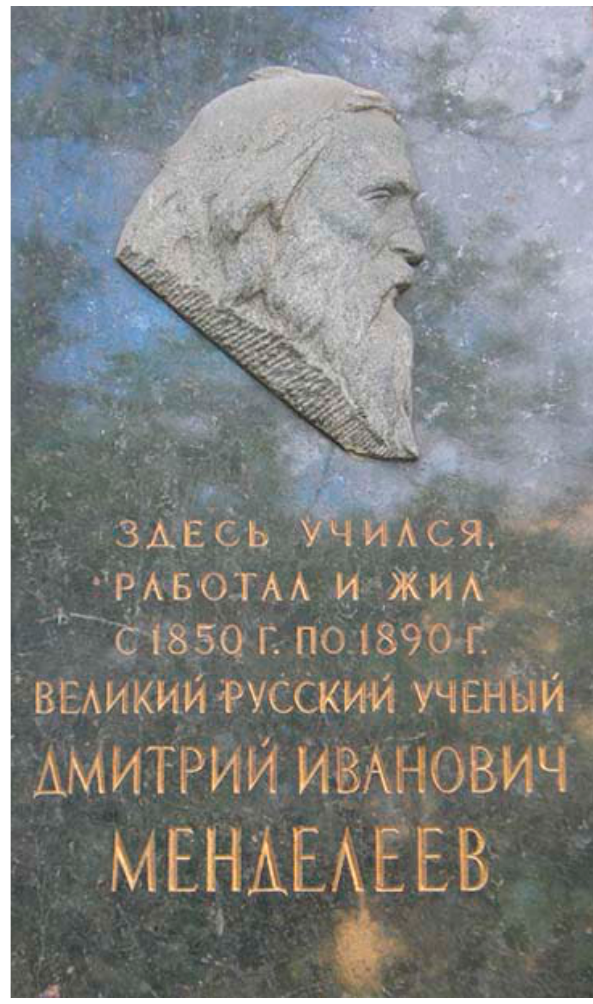
Figure 1. Plaque at the Entrance of the Mendeleev Museum and Archives. Courtesy of Jan and Mary Kochansky. It reads: “Here the and lived from 1850-1890.” 3